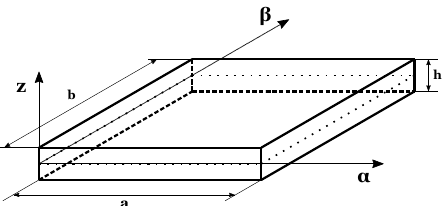
Figure 3. The square plate geometry for Case 1.